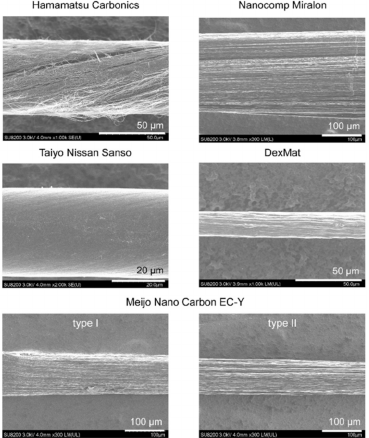
Figure 1. Side-view SEM images of CNT